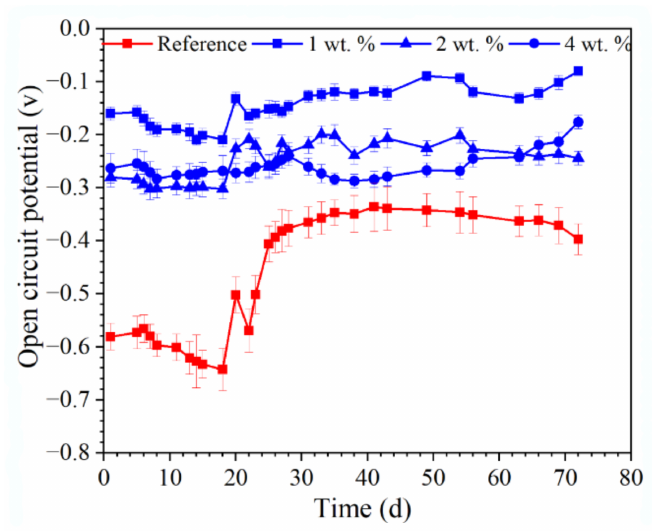
Figure 9. OCP of the reinforcement imbedded in concrete immersed in 3.5 wt.% NaCl